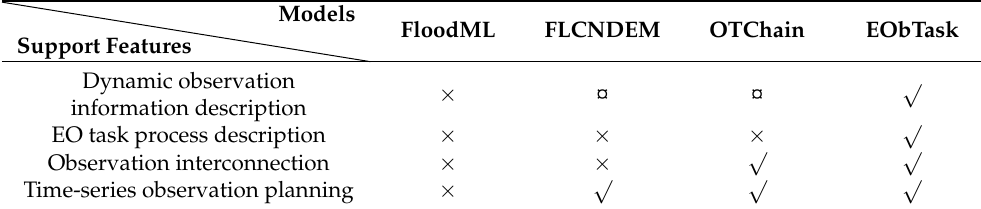
Table 2. Comparison of flood disaster information